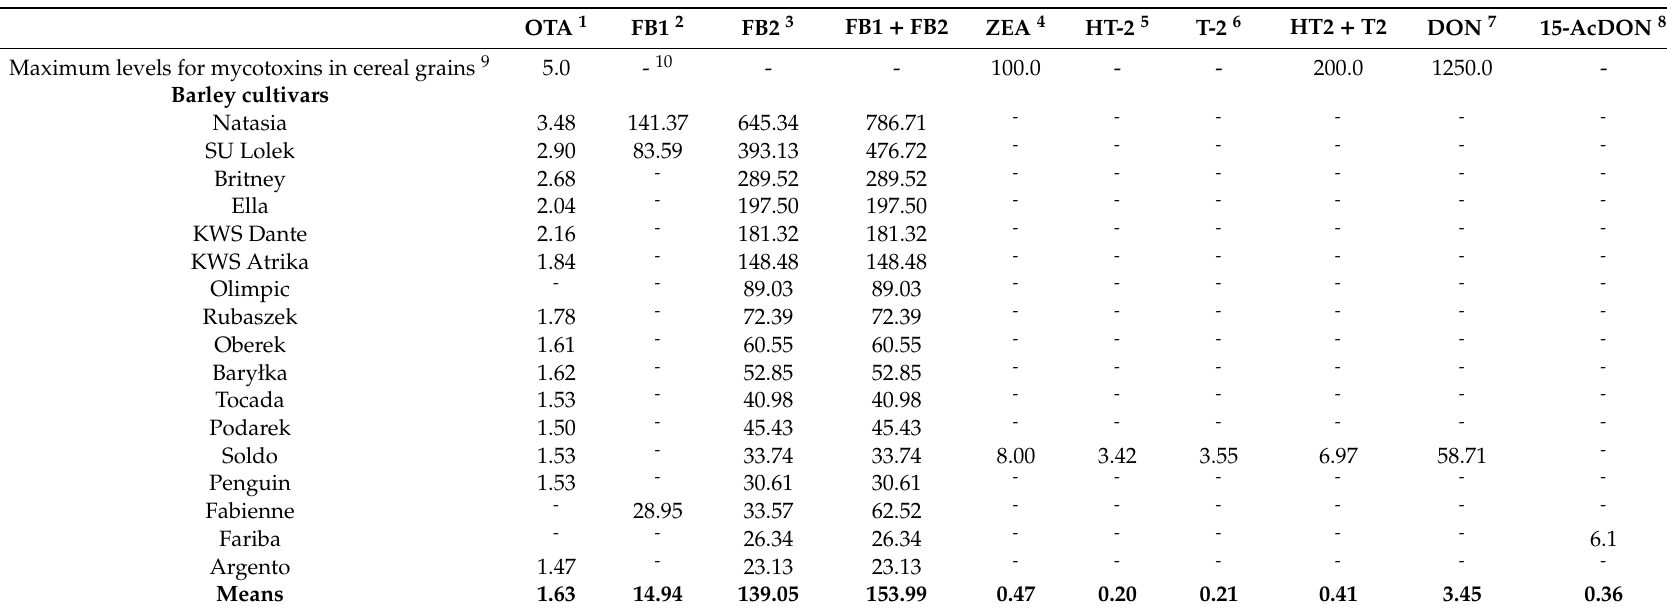
Table 7. Concentrations ( µ g kg − 1 ) of mycotoxins found in grains of 17 barley cultivars grown organically in the controlled field trial in